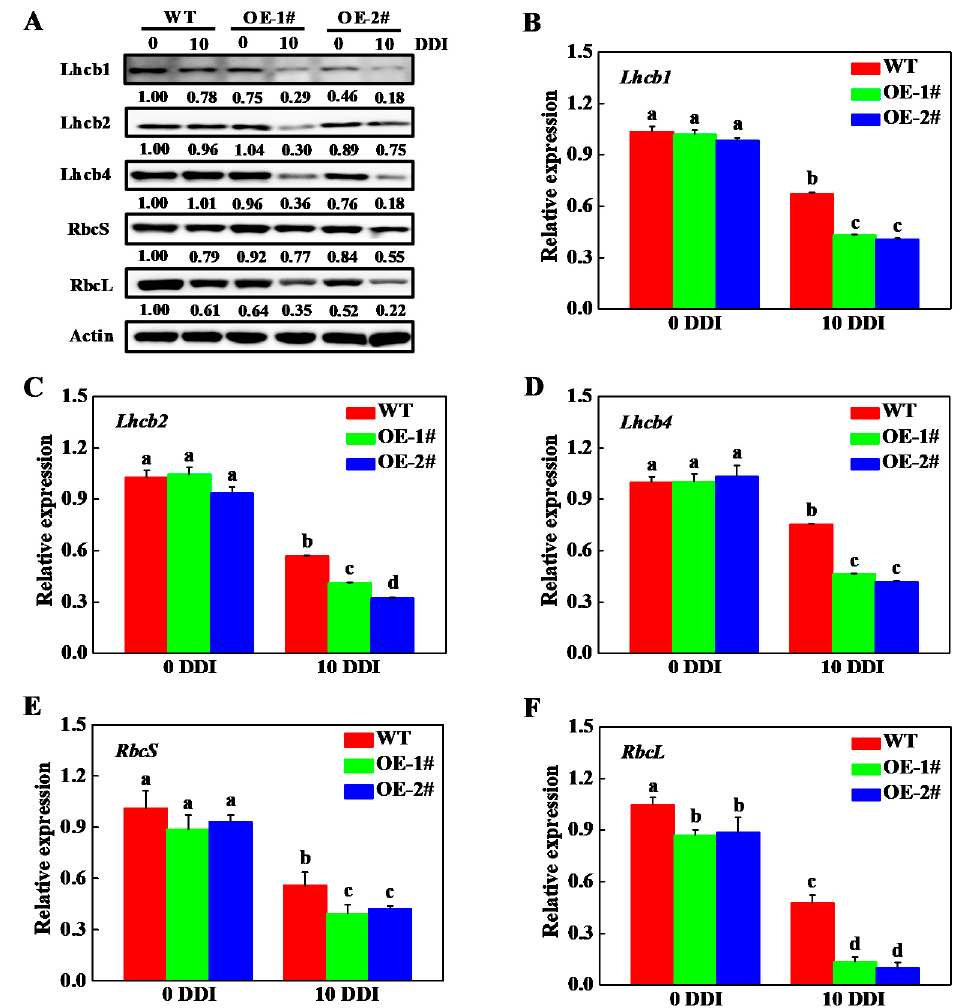
Figure 7. The abundance of photosystem proteins and the expression of related genes in CsHCAR overexpression transgenic tobacco seedlings. ( A ) Immunoblotting analysis of the protein abundance of photosystem proteins. The band intensity was quantified using Image J software to calculate to the protein level relative to the 0 d of WT plants, which was set to 1. The relative protein level is shown under the band; ( B ) the expression of Lhcb1 ; ( C ) the expression of Lhcb2 ; ( D ) the expression of Lhcb4 ; ( E ) the expression of RbcS ; ( F ) the expression of RbcL . The results represent the mean ± SE ( n = 3). Means with the same letter did not significantly differ at p < 0.05 according to Tukey’s test. WT, wild-type; OE-1# and OE-2#, 2 independent transgenic tobacco overexpression of CsHCAR ; DDI, day(s) of dark incubation.